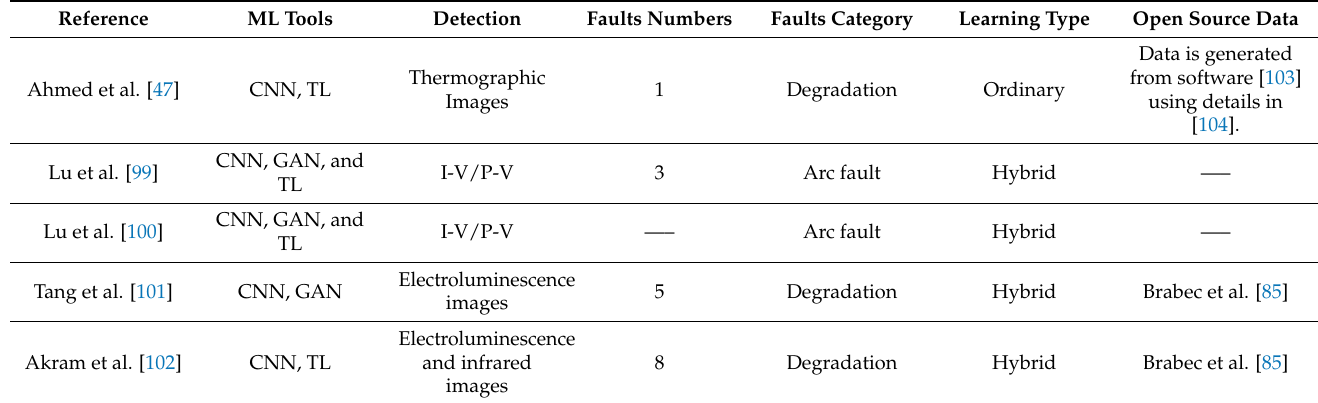
Table 3. Knowledge-guided methods for CM of PV systems.